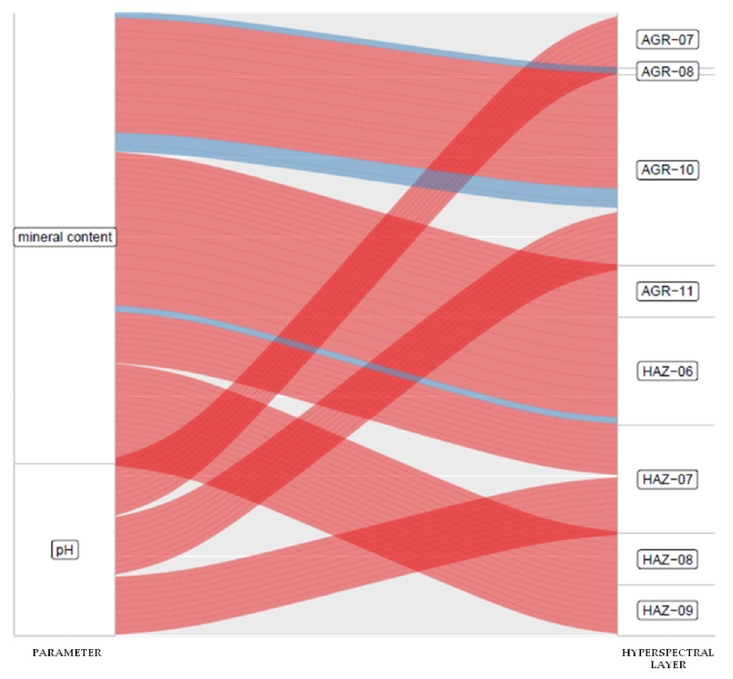
Figure 8. As in Figure 7, but for the Raw materials (“RM”) thematic area.